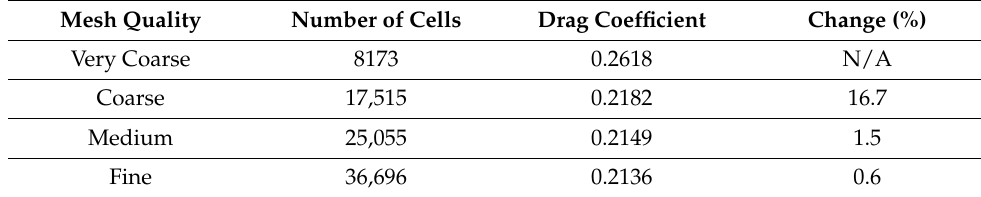
Table 2. Mesh Independence Study for Side View Female Model.